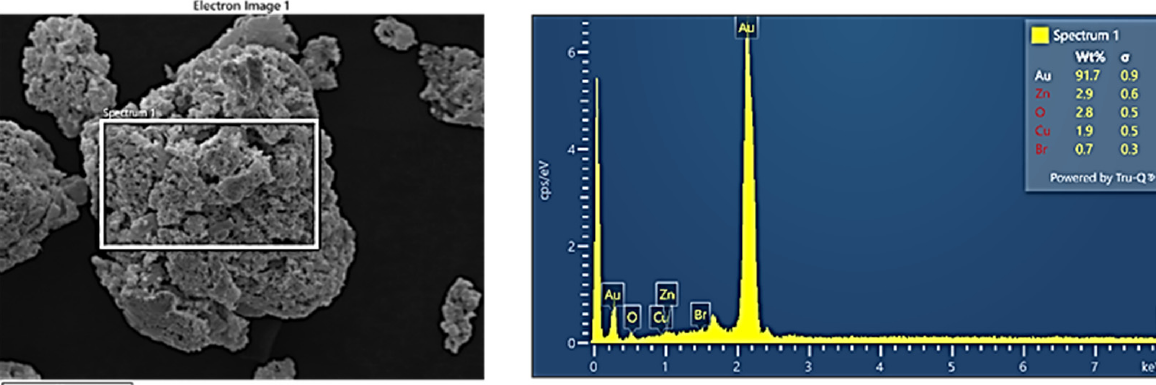
Figure 12. EDS (SEM) analysis of the produced gold powder.